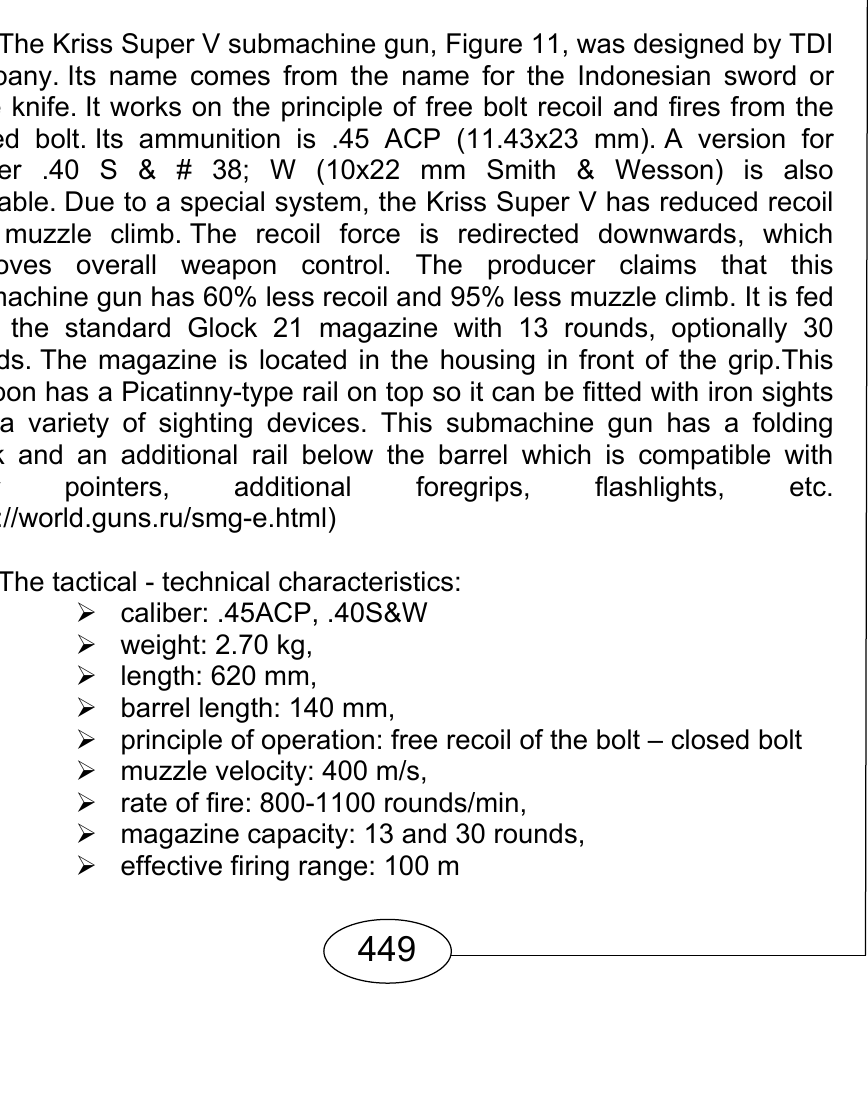
Figure 10 – Scorpion EVO III Submachine gun Рис . 10 – Автомат Scorpion E ВО 3 Слика 10 – Аутомат Scorpion EVO